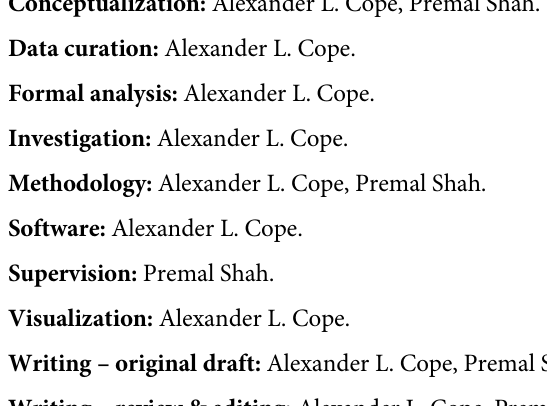
S1 Table. List of species and accessions for RNA-seq data used in this study. All data were download from NCBI’s Sequence Read Archive, except for L. kluyveri (European Nucleotide Archive).